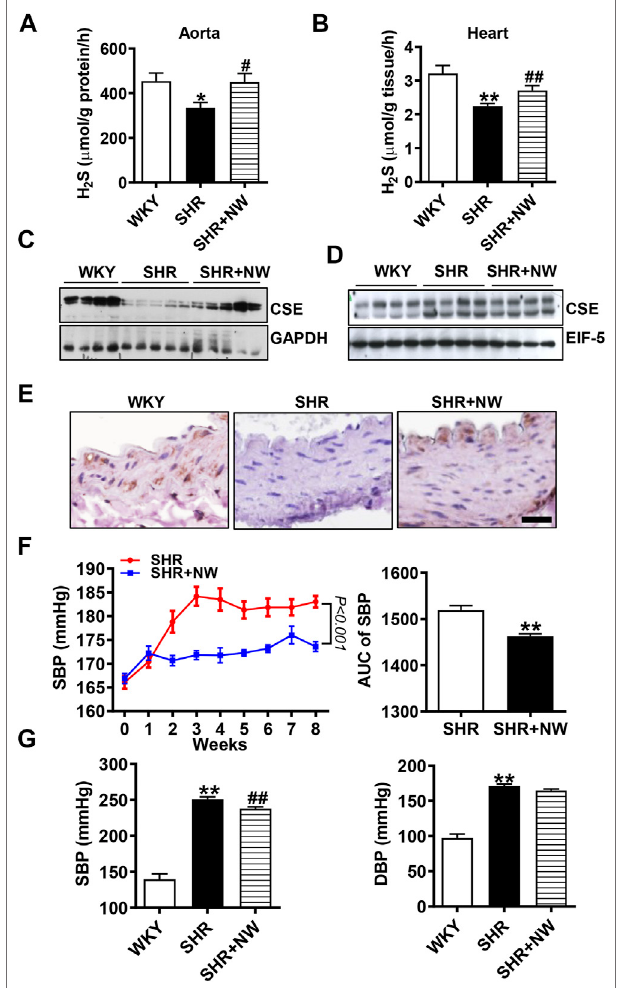
FIGURE 6 | NW treatment reduces blood pressure of SHRs. H 2 S production measurement by the methylene blue assay in the aorta (A) and heart (B) . The western blot assay analyzes CSE expression in the aorta (C) and heart (D) . Immunohistochemical staining of CSE in the aorta (E) , scalebar (cid:2) 25 μ m.BloodpressureofSHRsandSHRs +NWmonitoredbytail arteries; the right panel is area under the curve of the left panel (F) . 8 weeks after NW treatment, blood pressure was monitored by telemetry measurements (G) . N (cid:2) 10/group. * Versus WKY rats, # versus SHRs. * p < 0.05, ** p < 0.01.